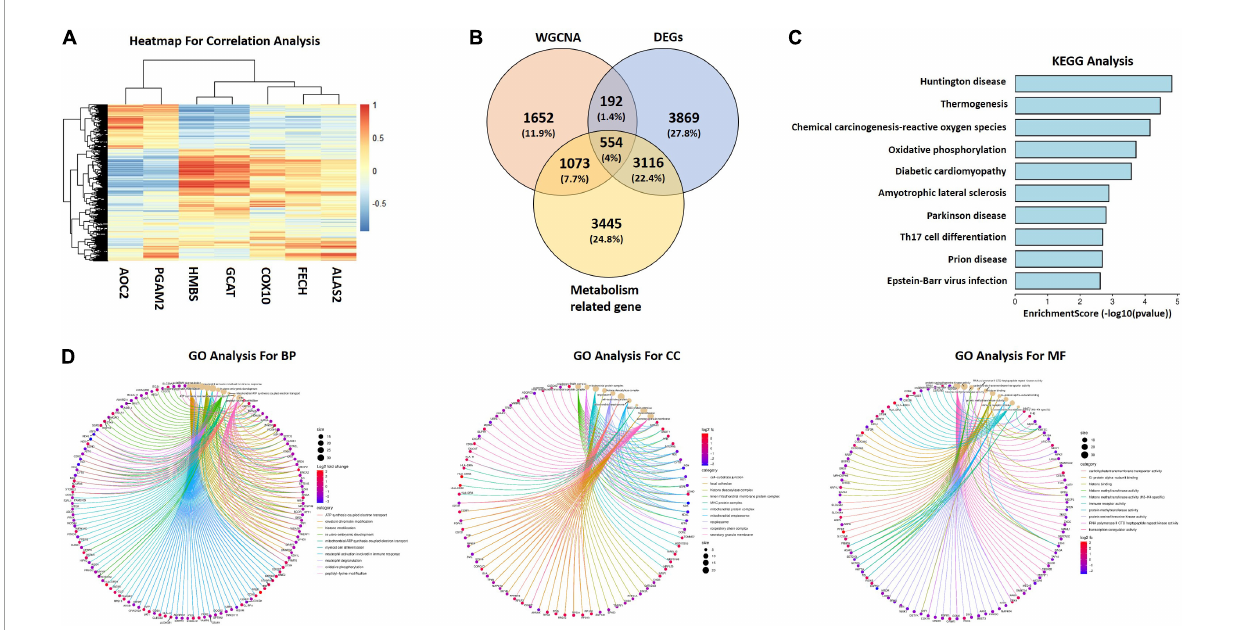
FIGURE4 Generation of metabolism related candidate hub genes. (A) Correlation heatmap between seven metabolism related genes and DEGs in GSE122709. Red represents positive correlations, and blue represents negative correlations. (B) Venn diagram to identify candidate hub genes between metabolism related genes, key modules genes and DEGs. (C) KEGG analysis of candidate hub genes. (D) GO analysis of candidate hub genes. WGCNA, weighted gene co-expression network analysis; DEGs, differentially expressed genes; KEGG, Kyoto Encyclopedia of Genes and Genomes; GO, Gene Ontology; BP, biological processes; CC, cellular components; MF, molecular functions.